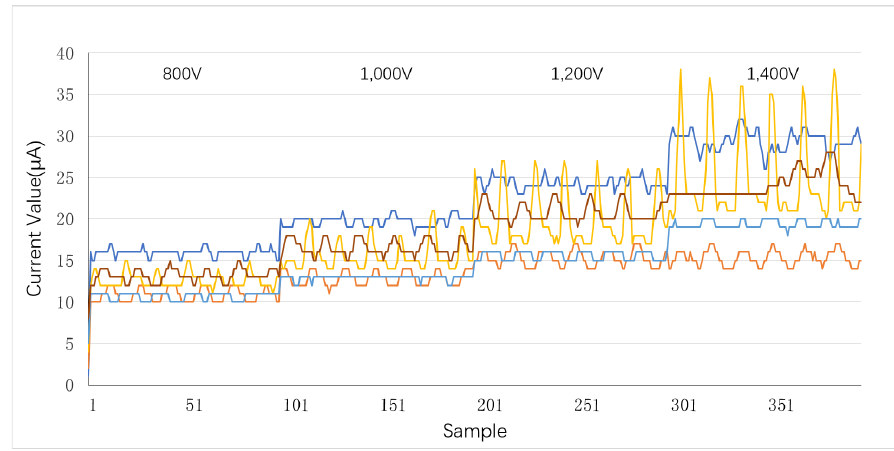
Figure 16. Current signal when the egg had no discharge phenomenon under different voltages.